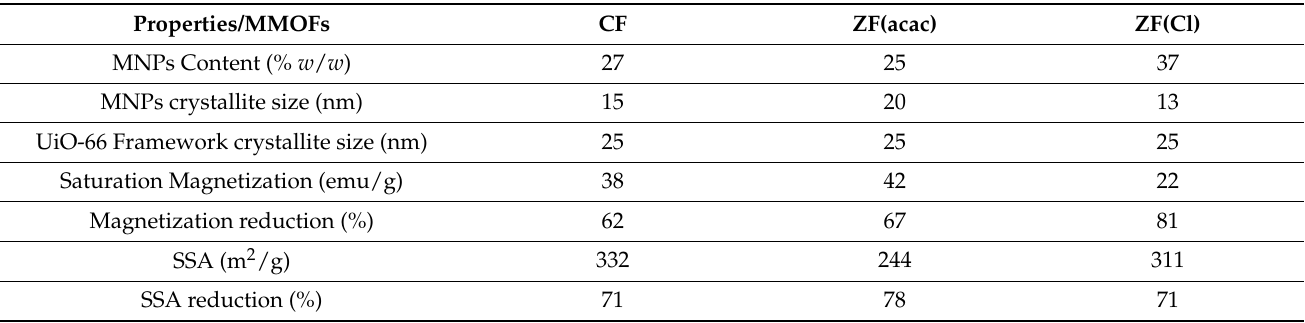
Figure 8. N 2 Absorption isotherms for UiO-66, CF MMOF, ZF(acac) MMOF and ZF(Cl) MMOF. Table 1. MMOFs physicochemical traits.